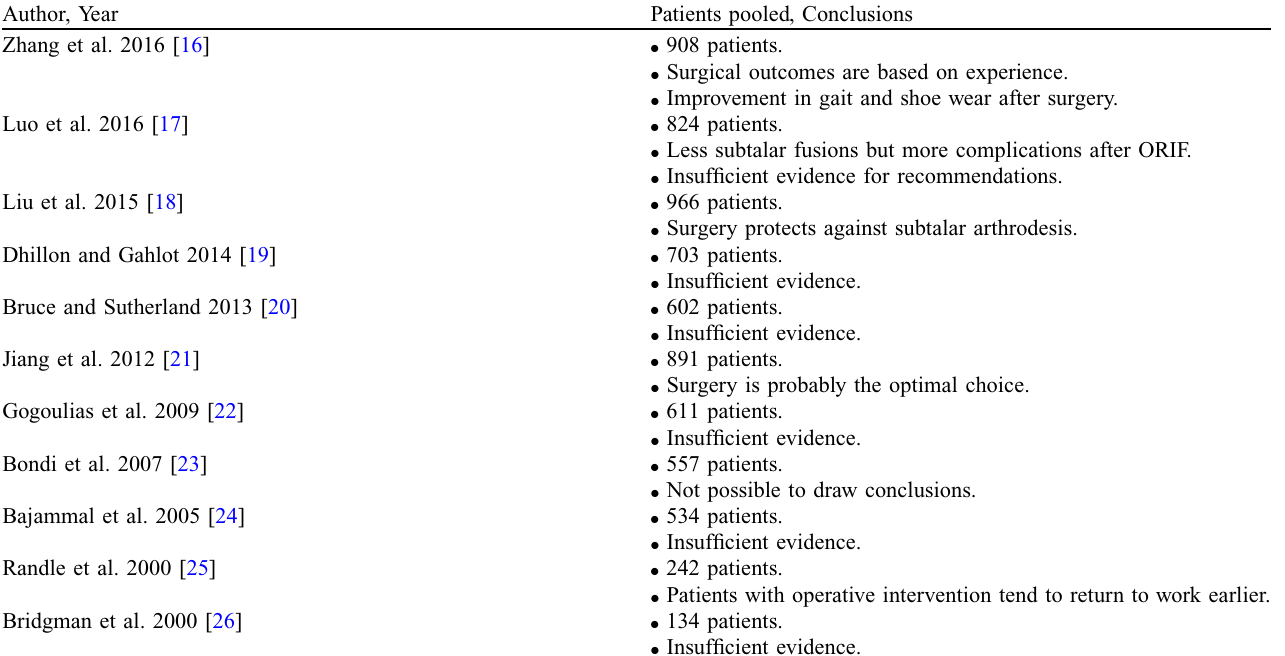
Table 2. Overview of meta-analysis on displaced intra-articular calcaneus fractures. Author,